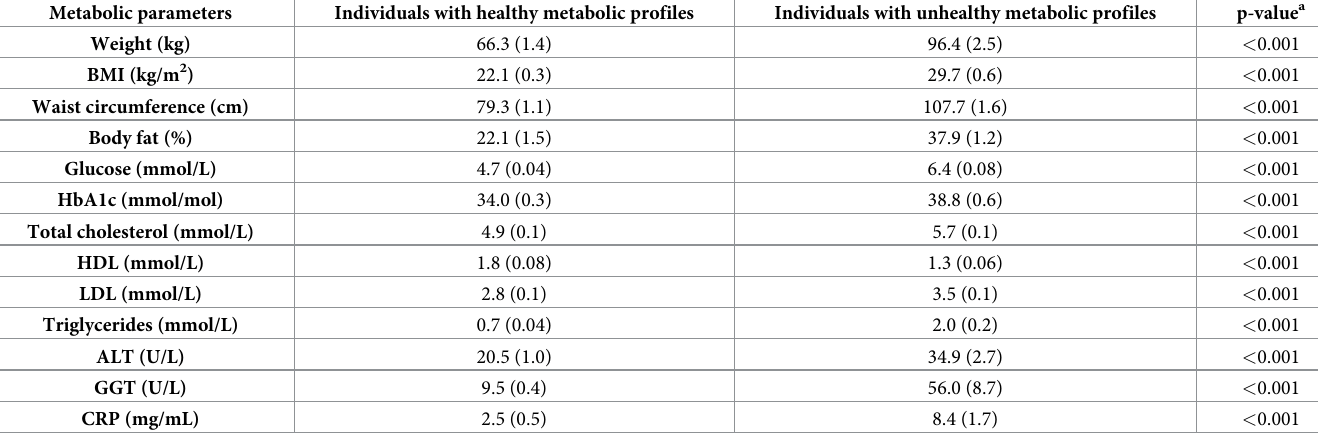
Table 1. Metabolic characteristics (mean ± SE) of individuals with healthy (n = 40) and unhealthy (n = 40) metabolic profiles in the pilot study.